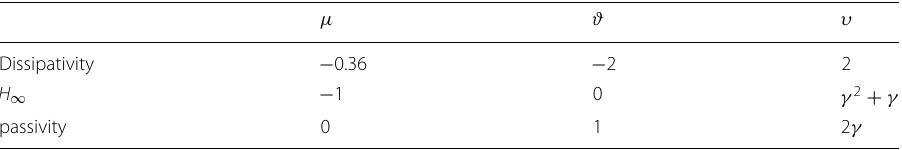
Table 3 The values of µ , ϑ and υ for different performances